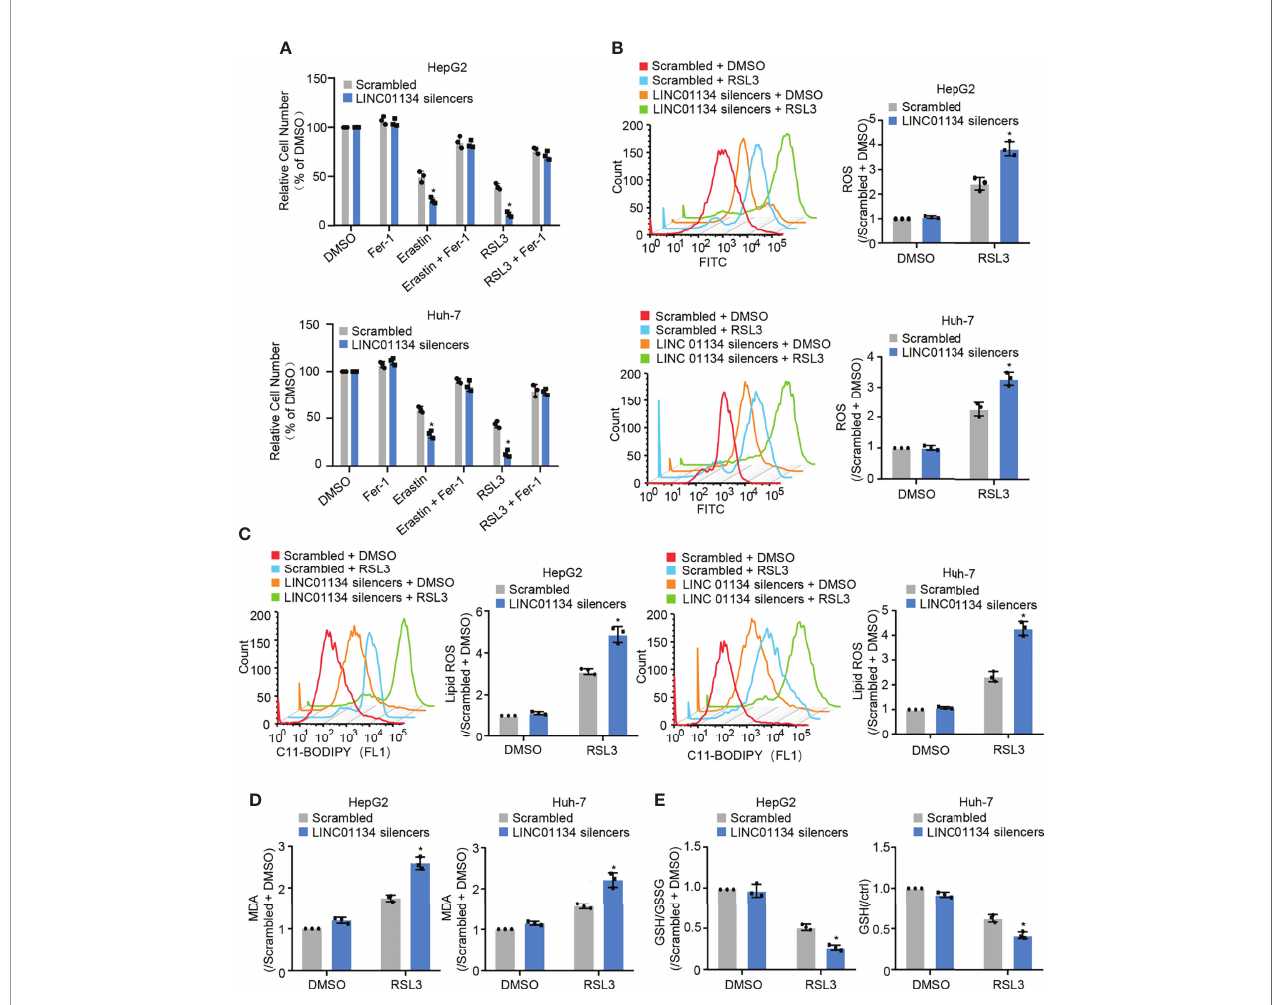
FIGURE 2 | Silenced LINC01134 enhances sensitivity of HCC cells to OXA and promotes RSL3-induced ferroptosis. (A) Huh-7 and HepG2 cells were transfected with scrambled or LINC01134 silencers with or without treatment of RSL3 (2 m M), erastin (10 m M), and ferrostatin (2 m M). The histogram shows relative cell number measured by CCK-8 assays. (B-E) HepG2 and Huh-7 cells were transfected with scrambled or LINC01134 silencers with or without RSL3 (2 m M). Levels of total ROS (B) , lipid ROS (C) , Lipid Oxidation (MDA) (D) and GSH/GSSG (E) were analyzed. Data are shown as the mean ± SEM; n ≥ 3 independent experiments, two-tailed Student ’ s t-test: *P <